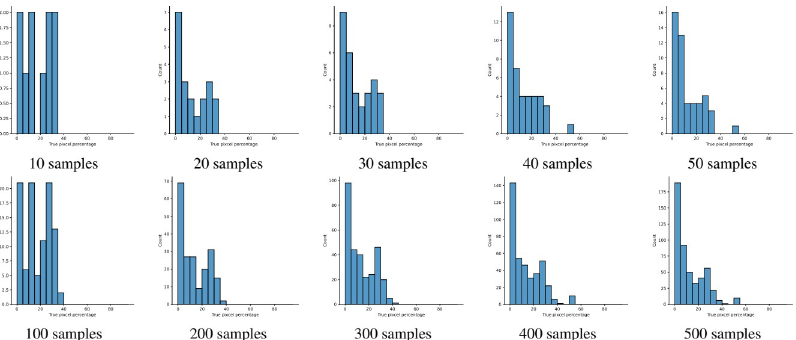
Fig 10. Distribution comparison between real (top row) and synthetic (bottom row) masks. Synthetic masks were generated using the